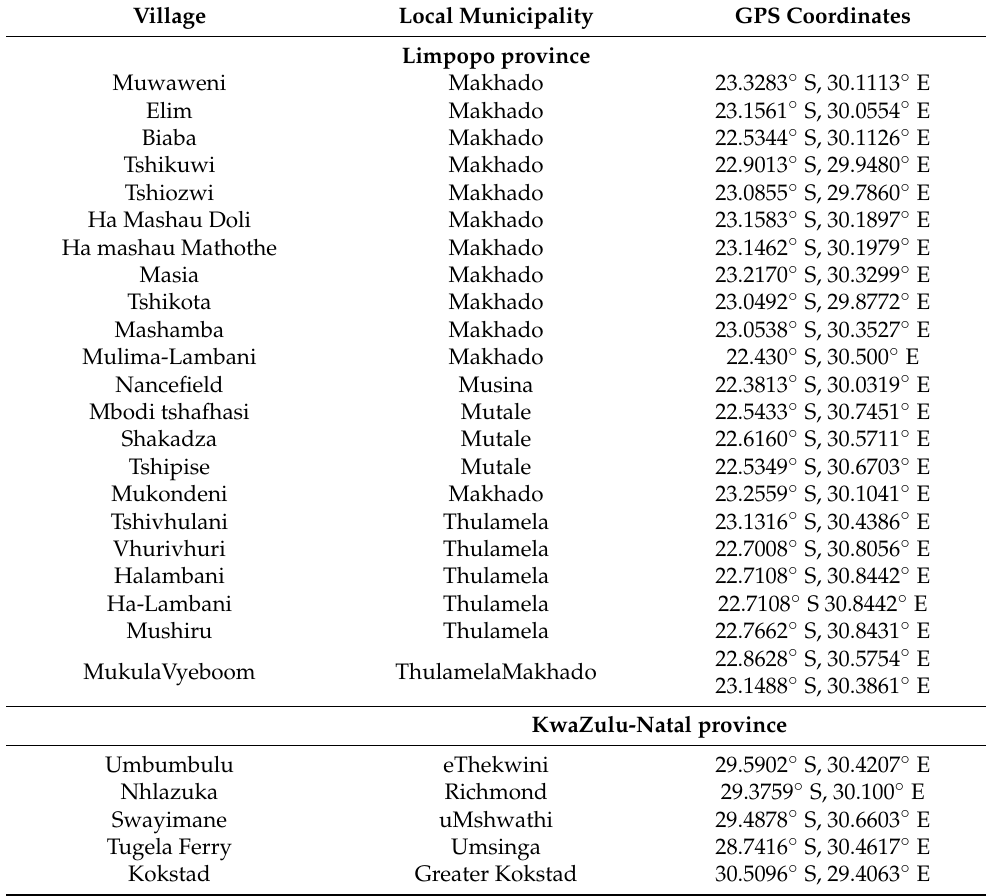
Table A1. Number of villages sampled in different local municipalities in Limpopo and KwaZulu-